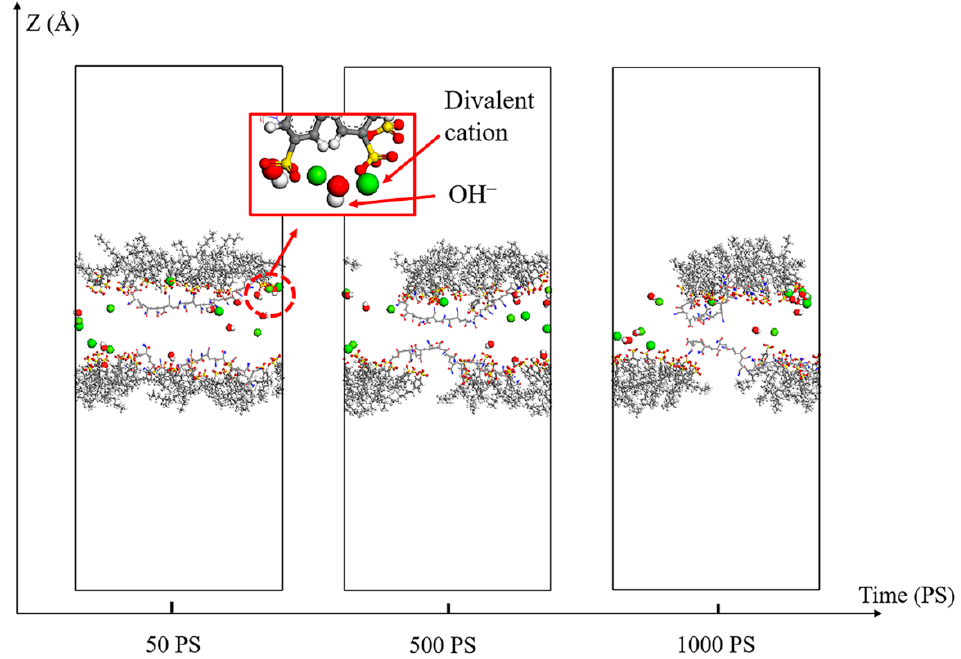
Figure 12. Snapshots of the liquid film in the “SDBS/HPAM/OH − ” system during the dynamic relaxation process.